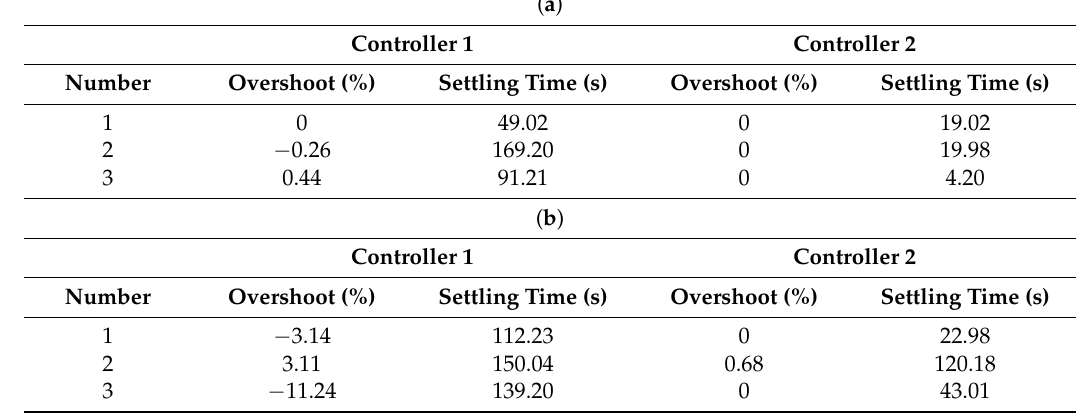
Table 2. ( a ) Detailed data of the simulation result of T e,sec,out ; ( b ) Detailed data of the simulation result of T sh